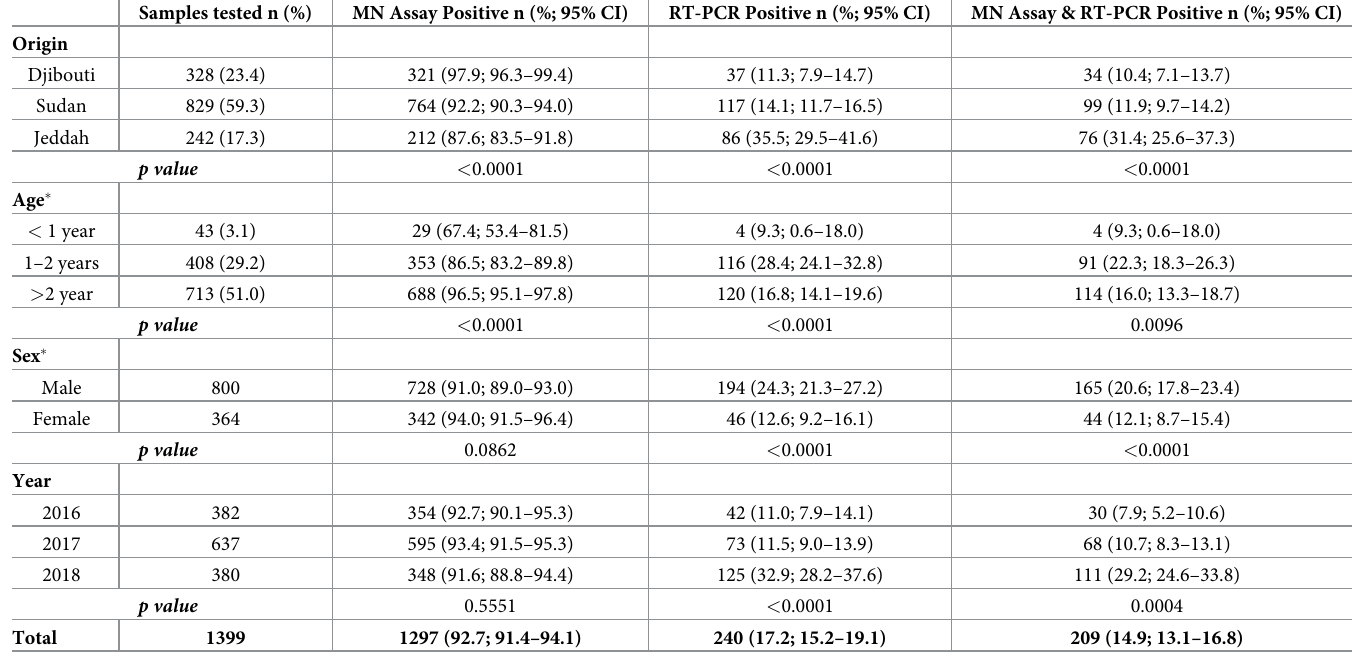
Table 1. Overall positivity for MERS-CoV nAbs and RNA in imported and local dromedaries in Saudi Arabia. Samples tested n